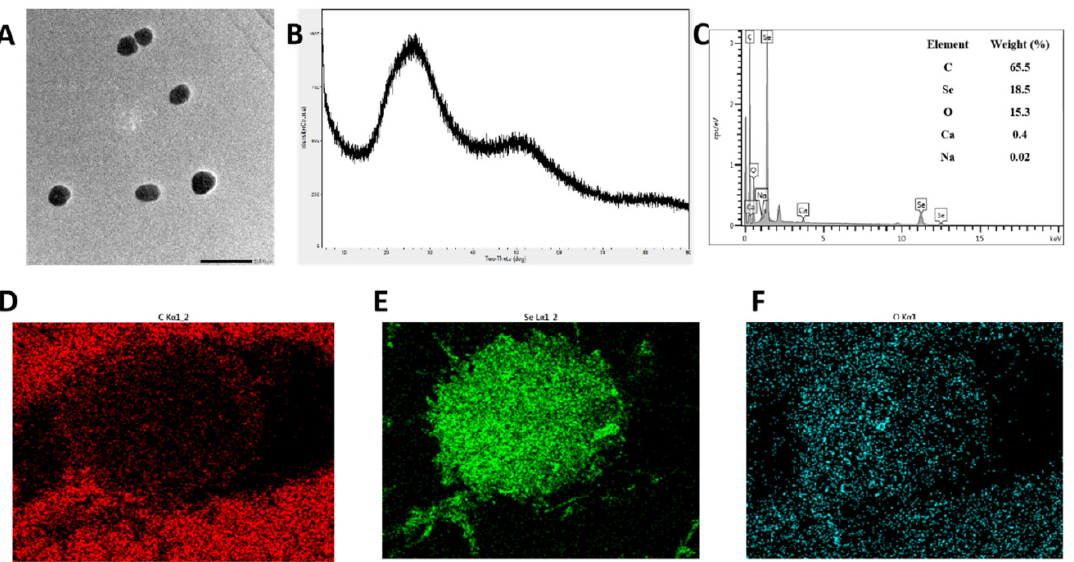
Figure 5. SCP-Se NP characterization. ( A ) TEM image of SCP-Se NPs. ( B ) XRD spectrum of SCP-Se NPs. ( C ) The elemental composition of SCP-Se NPs. ( D ) Carbon. ( E ) Selenium. ( F ) Oxygen.